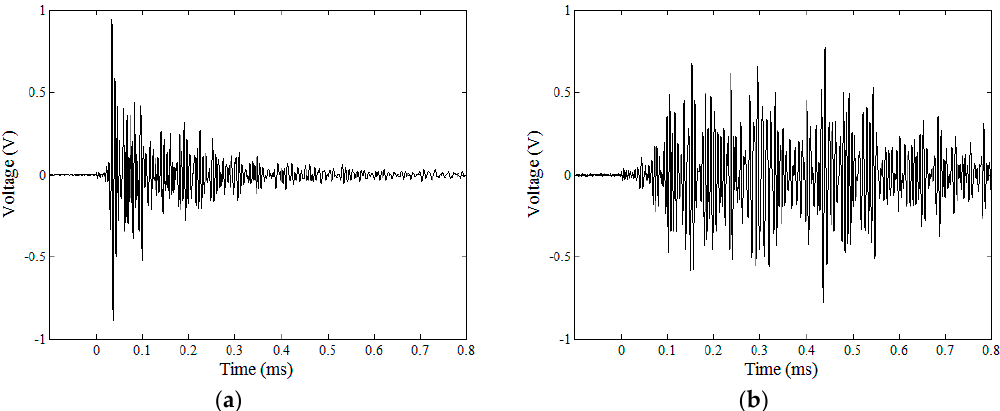
Figure 4. Schematic illustration of the test setup for diffuse ultrasound: ( a ) Side view; ( b ) Top view.